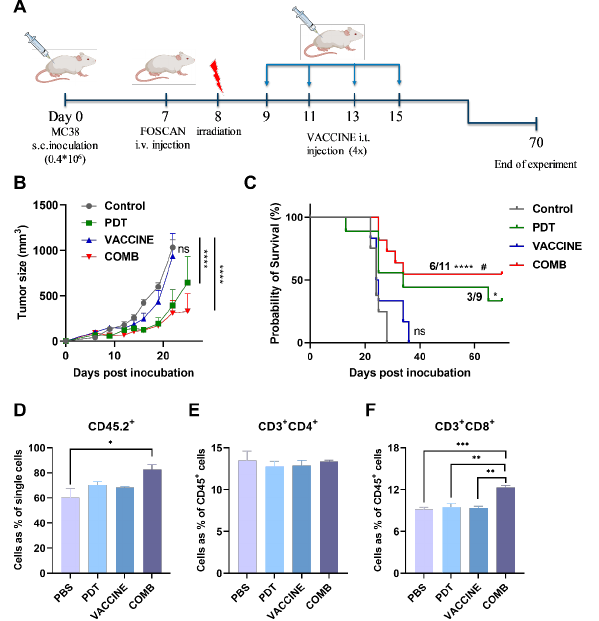
Figure 5. FOSCAN-PDT in combination with HBc VLPs in MC-38 tumor-bearing mice. ( A ) Graphical overview of the experimental design of the MC-38 tumor model, i.t., intratumoral injection. ( B ) The average size of MC-38 tumors of mice after treatment with PBS (Control), FOSCAN-PDT (PDT), HBc VLP vaccine (VACCINE), and PDT combination with the vaccine (COMB). Tumor volume data were presented as means ± SEM and analyzed by a two-way ANOVA. ( C ) The survival times of subgroups by plotting Kaplan – Meier survival curves. Survival analysis was performed with a Log-rank test (* p < 0.05, ** p < 0.01, *** p < 0.001, and **** p < 0.0001 by comparing to PBS group; # p < 0.05 by comparing VACCINE to COMB group). One day after the second vaccine injection, mice (n ≥ 3) from different subgroups were sacrificed and spleens were collected, processed, and stained for further analysis of the immune cell population by means of flow cytometry. ( D ) CD45.2 + cell population, ( E ) CD4 + T cell population, and ( F ) CD8 + T cell population. The statistical differences are denoted as ns: not significant, * p < 0.05, ** p < 0.01, *** p < 0.001, and **** p < 0.0001.